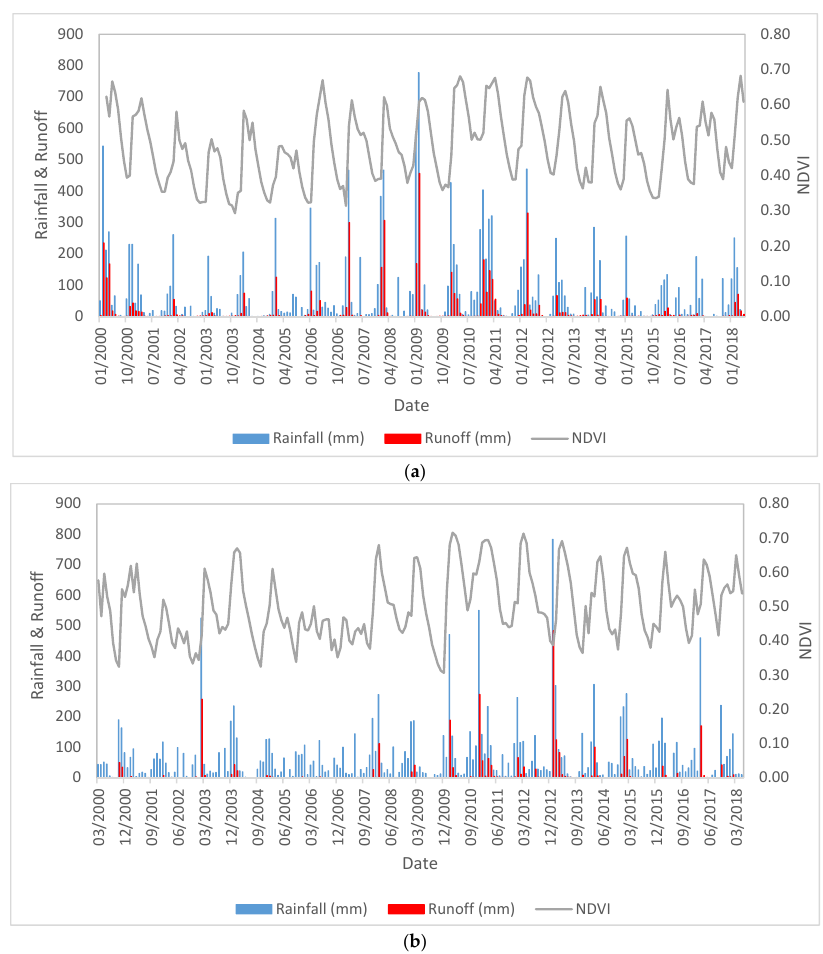
Figure 3. Monthly NDVI time series plot compared with monthly rainfall and runoff data for the Haughton River catchment ( a ) and the Calliope River catchment ( b ) (2000 to 2018).